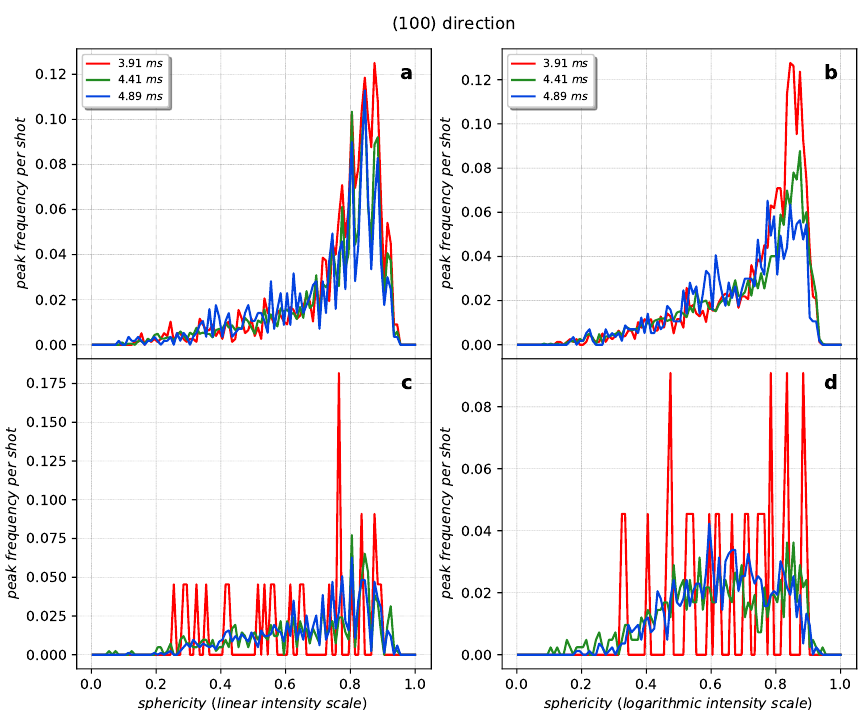
Figure A3. Frequency of a peak appearing with a certain sphericity for the (100) direction for the hits above 50 ADU/pixel ( a ) in linear and ( b ) in logarithmic intensity scales as well as the hits below 50 ADU/pixel ( c ) in linear and ( d ) in logarithmic intensity scales.